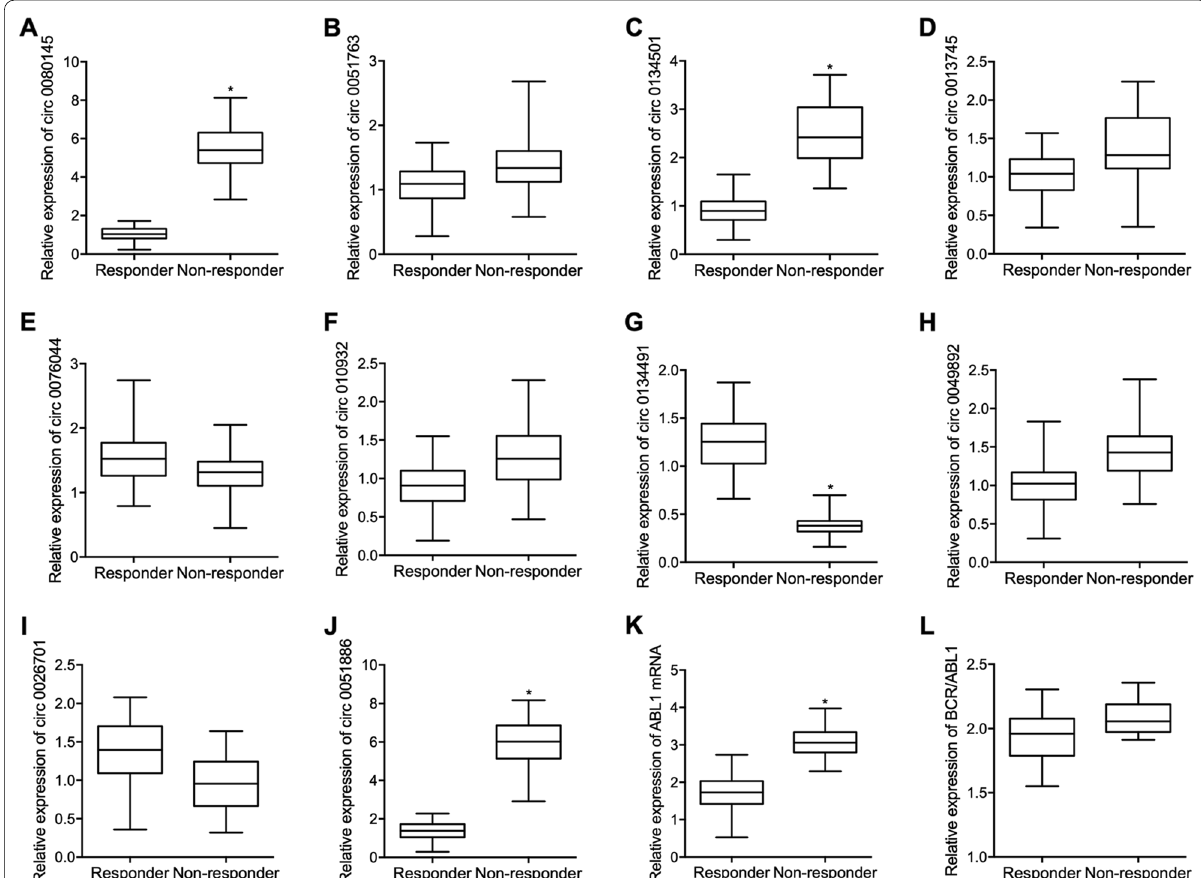
Fig. 1 Among all candidate circRNAs, circ_0080145, circ 0134501, circ 0134491 and circ_0051886 were dysregulated between different CML patient groups, and unlike BCR/ABL1, the level of ABL1 mRNA was higher non‑responder patients (*P value < 0.05 vs. responder group). A The relative expression level of circ_0080145 was higher in CML patients sensitive to IM; B The relative expression levels of circ 0051763 were similar in different CML patient groups; C The elative expression level of circ 0134501 was higher in CML patients sensitive to IM; D The relative expression levels of circ 0013745 were similar in different CML patient groups; E The relative expression levels of circ 0076044 were similar in different CML patient groups; F The relative expression levels of circ 0109320 were similar in different CML patient groups; G The relative expression level of circ 0134491 was lower in CML patients sensitive to IM; H The relative expression levels of circ 0049892 were similar in different CML patient groups; I The relative expression levels of circ 0026701 were similar in different CML patient groups; J The relative expression level of circ_0051886 was higher in CML patients sensitive to IM; K The relative expression level of ABL1 mRNA was higher in CML patients sensitive to IM; L The relative expression levels of